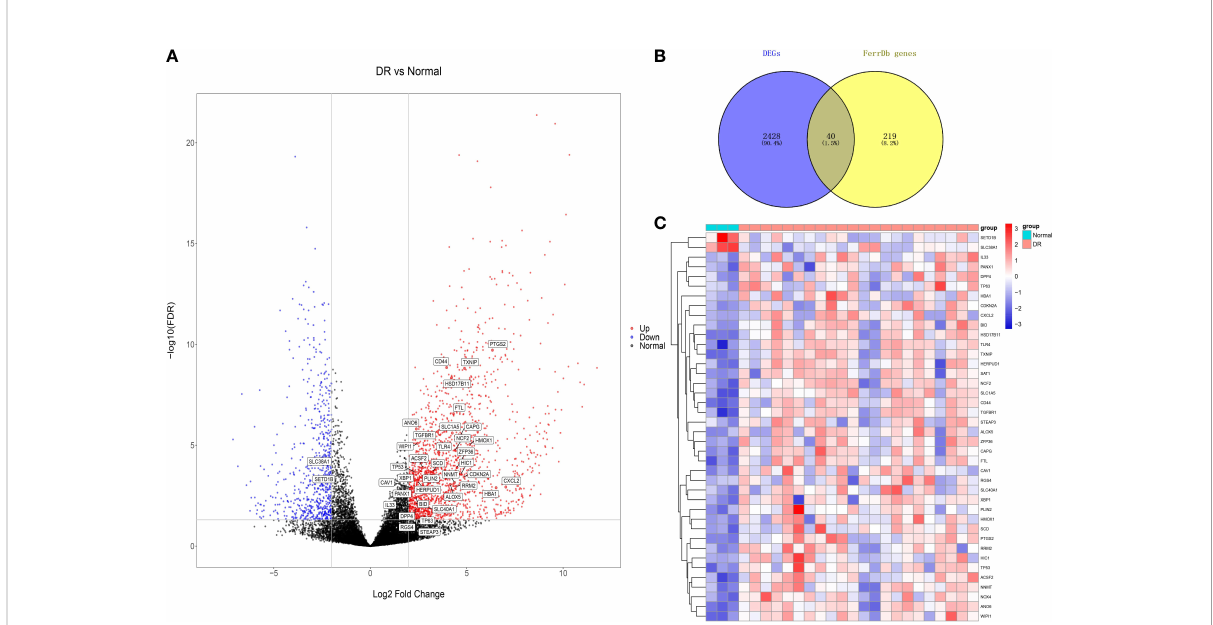
FIGURE 2 Differentially expressed genes (DEGs) analysis. (A) Volcano plot of DEGs. (B) Venn diagram of ferroptosis-related DEGs, and their gene symbols were shown in (A) . (C) Heat map of ferroptosis-related DEGs. DR, diabetic